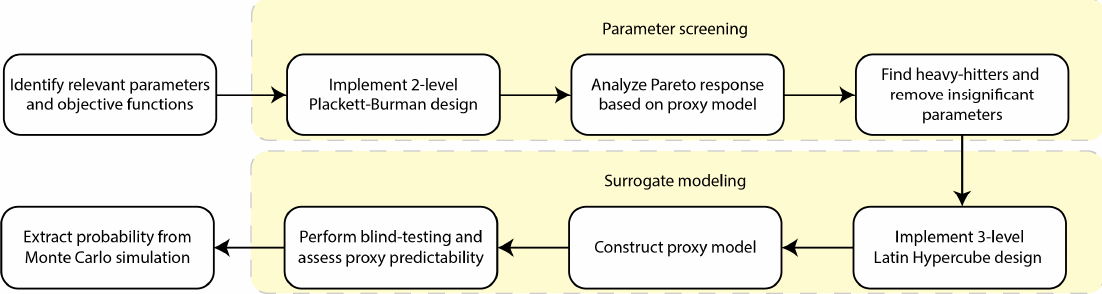
Figure 9. Simplified schematic showing the overall Design of Experiments workflow used in this paper, following the recent work of Santoso et al. (2019).